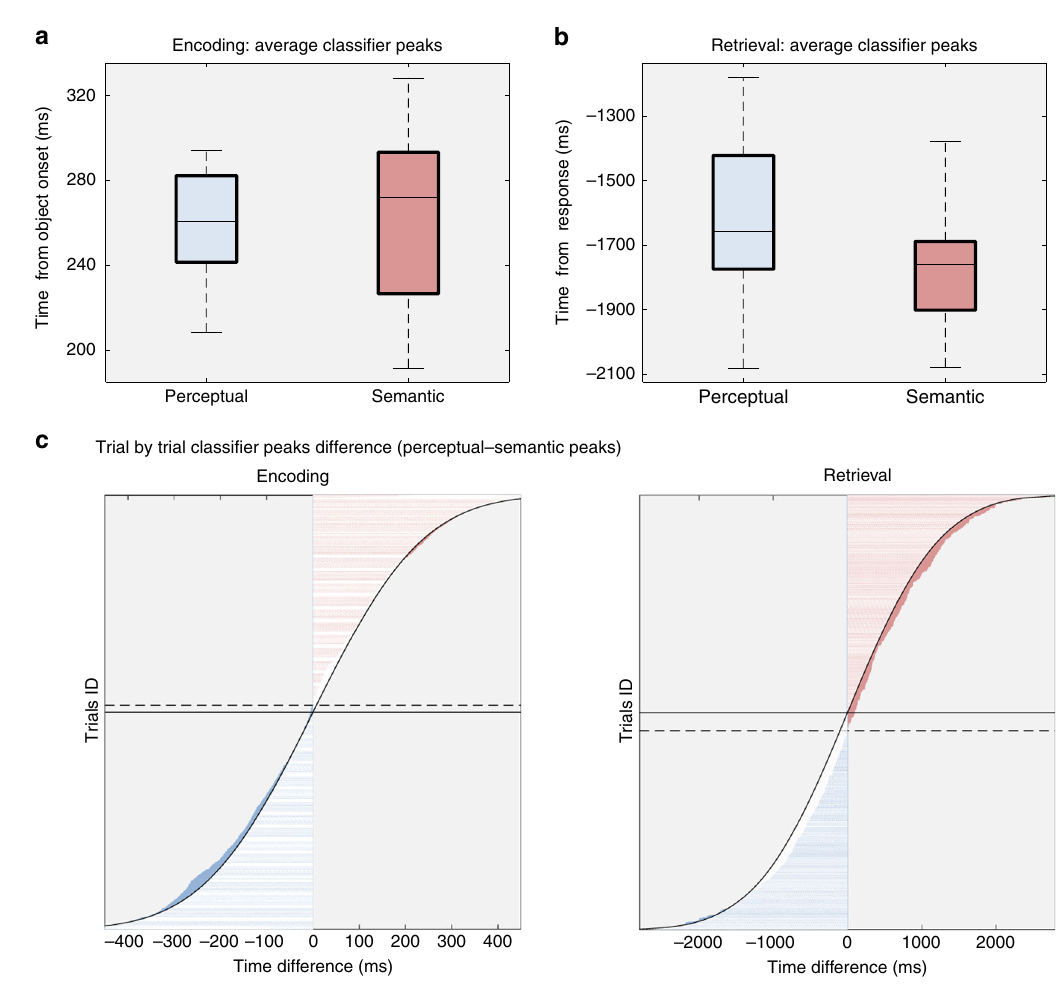
Fig. 4 EEG multivariate analysis results. For illustrative purposes, box plots show group peak distributions of d values for perceptual and semantic categories during encoding ( a ; Perceptual peaks: M = 259 ms, SD = 24 ms; Semantic peaks: M = 267 ms, SD = 43 ms) and retrieval ( b ; Perceptual peaks: M = − 1646 ms, SD = 247 ms; Semantic peaks: M = − 1772 ms, SD = 177 ms) after averaging peaks within participants. All box plot elements represent the same metrics as in Fig. 2. c Measuring classi fi er fi delity in terms of d value peaks on a single-trial level allowed us to measure the pairwise time distance between perceptual and semantic peaks during encoding (left panel) and retrieval (right panel). Y -axis represents each individual trial, with trials accumulated across participants. The time distance between classi fi er peaks (time of perceptual peak minus time of semantic peak on a given trial) is represented on the X -axis. The curved line represents an expected normal distribution. The solid horizontal line indicates the 50% point (half of the trials), and the dashed horizontal line indicates the point where the temporal distance values change sign from perceptual < semantic (blue) to